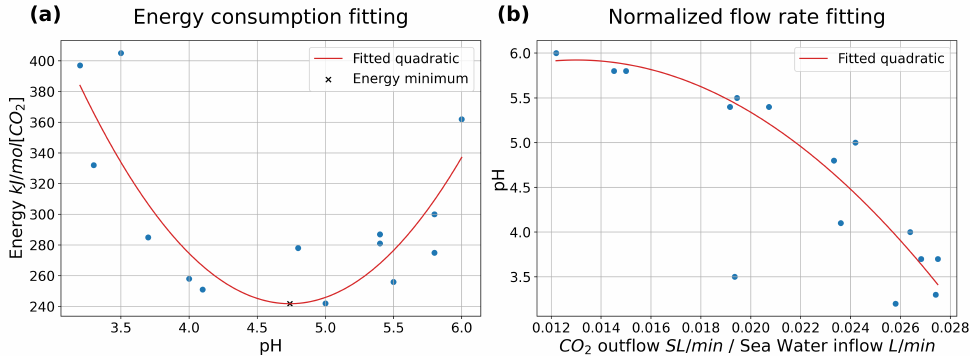
Figure 7. The fitted quadratic curves for the energy consumption per mole of extracted CO 2 depending on pH ( a ), and for pH versus the ratio of outflow CO 2 over inflow seawater ( b ). The fitted equation for ( a ) is 58.29 x 2 − 524.44 x + 1423.21 = 0 where x = pH , and for ( b ) is − 1195.47 x 2 + 311.11 x + 3.90 − pH = 0 where x = the CO 2 outflow / seawater inflow